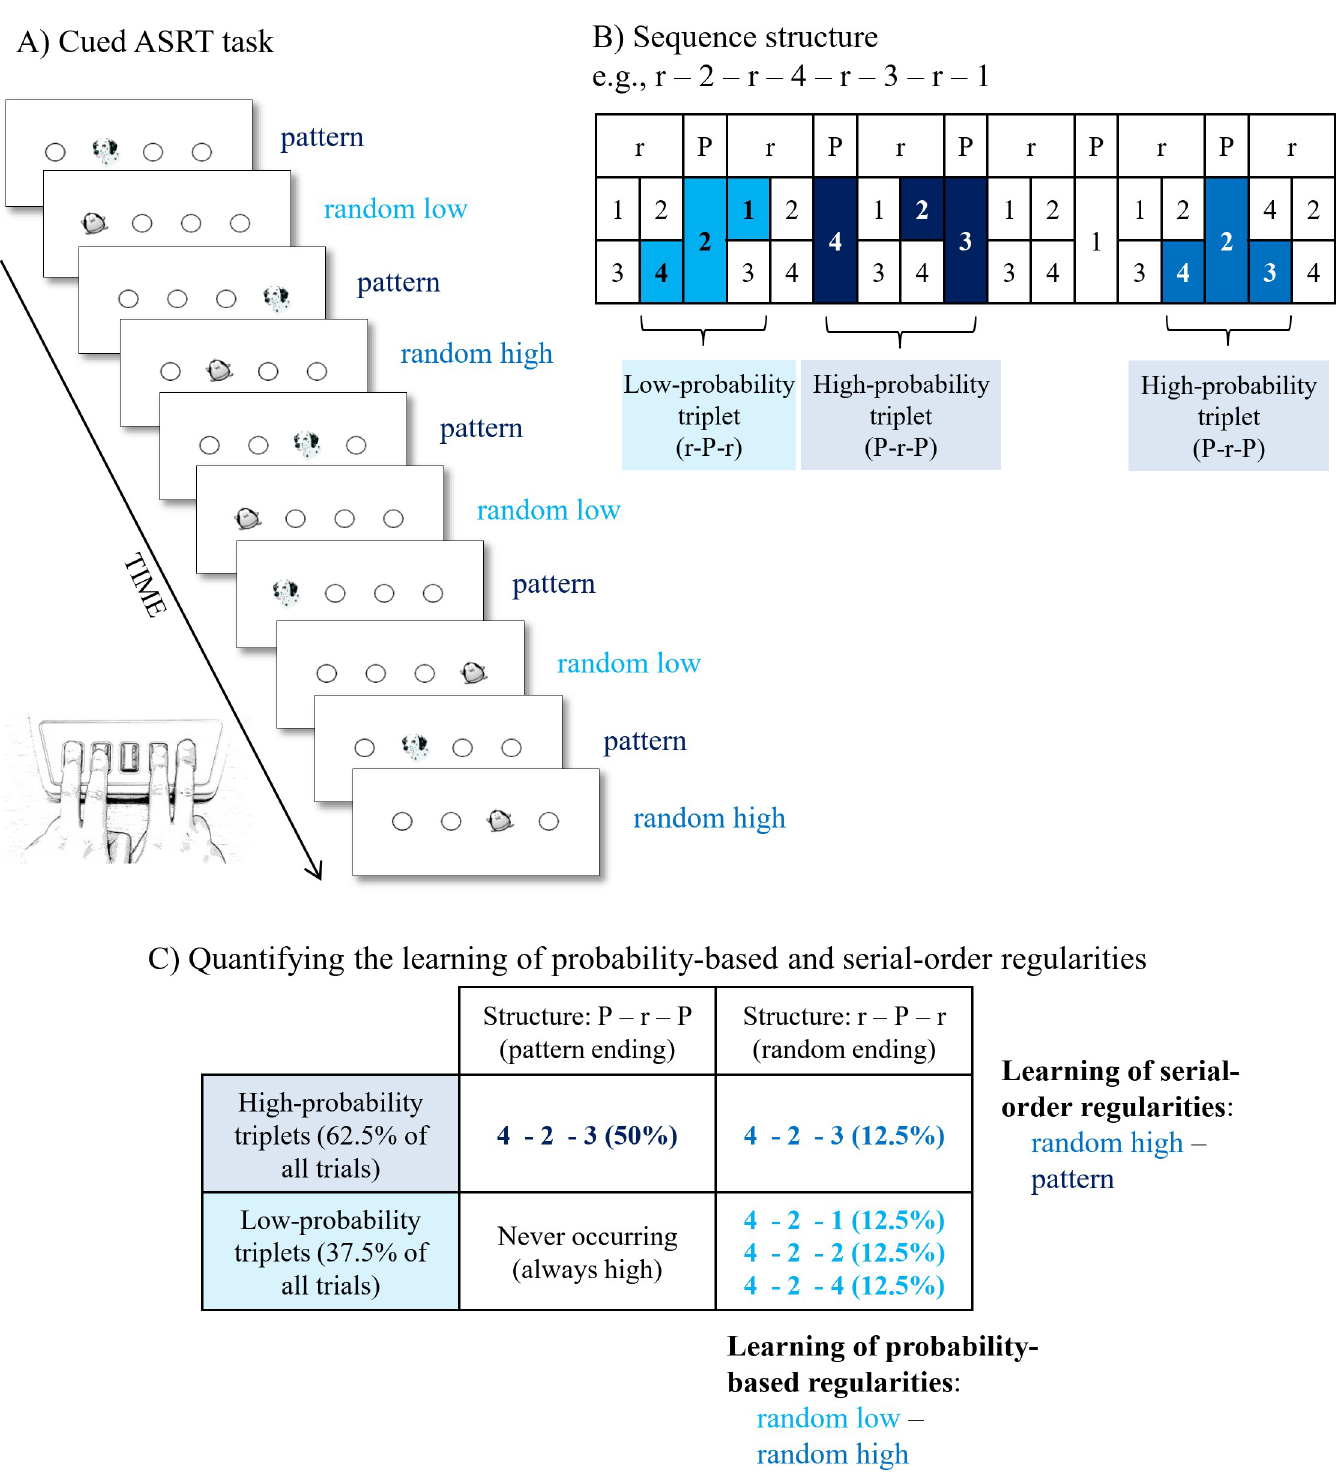
Fig 2. The cued Alternating Serial Reaction Time (ASRT) task. (A) Pattern and random trials were presented in an alternating fashion in the ASRT task. Pattern trials were indicated by a picture of a dog and random trials were indicated by a picture of a penguin. (B) An example of the alternating sequence structure. Here, numbers indicate pattern trials and ‘r’ indicates a randomly selected location. The alternating sequence makes some runs of three consecutive trials (called triplets) more probable than others, termed high- and low-probability triplets, respectively. Among high-probability triplets, we determined pattern high-probability triplets (dark blue shading in panel B and dark blue font in panel C) and random high-probability triplets (blue shading in panel B and blue font in panel C). Low-probability triplets can occur only